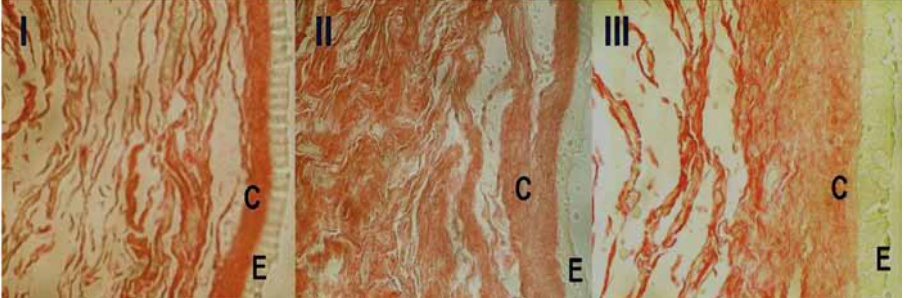
Figure 3 - Evaluation of collagen. I: control; II: 15 days after the graft; III: 90 days after the graft. Picrosirius-red (Magnification 400X). c (colagen), E